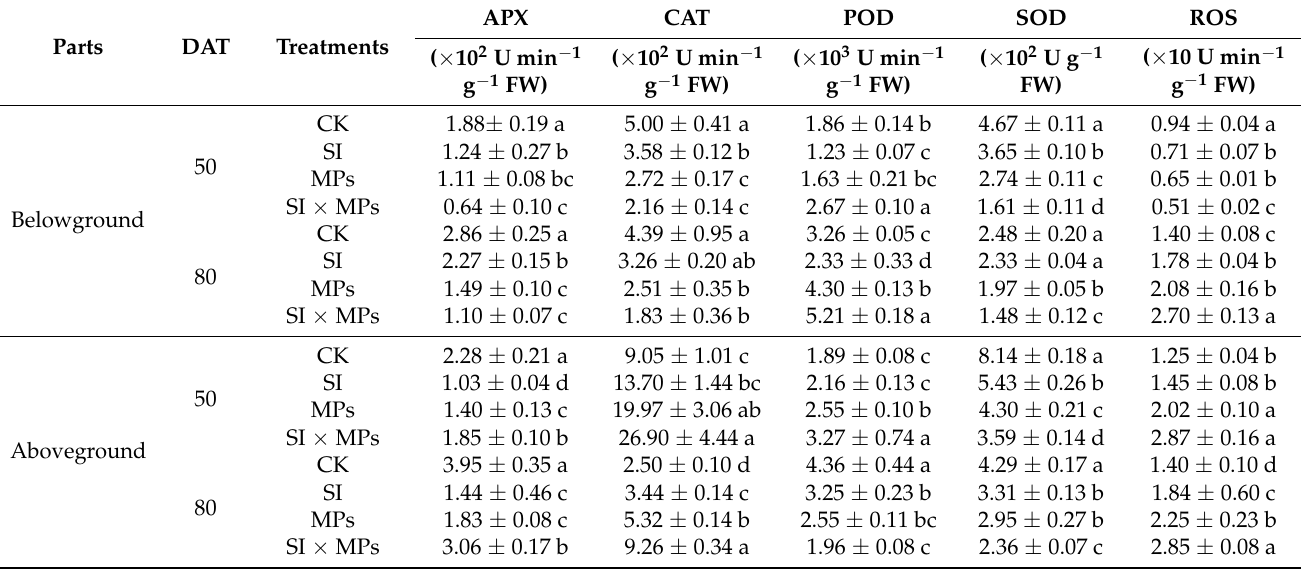
Table 4. Mean antioxidant enzyme activities and reactive oxygen species in the belowground and aboveground parts of the rice under different treatments at the 50th and 80th days after transplanting, presented as the mean ± standard error ( n =